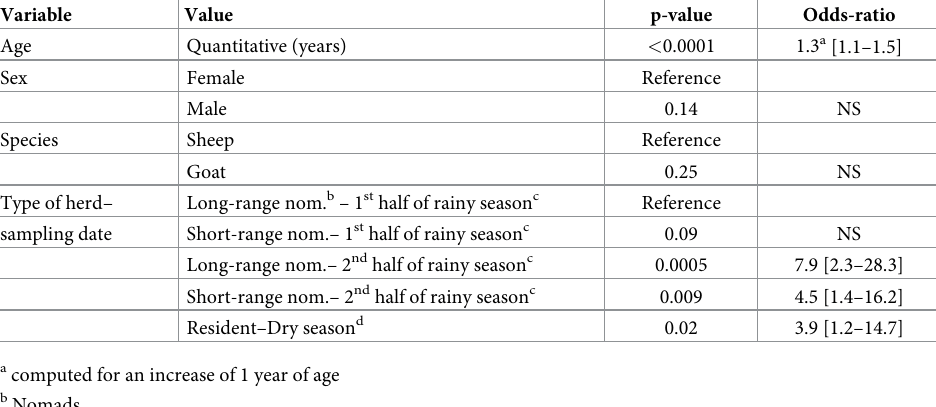
Table 5. Logistic mixed model of the association between seropositivity with individual-level and group-level covariates in small ruminants from resident and nomadic herds of Younoufere area, Ferlo, Senegal,